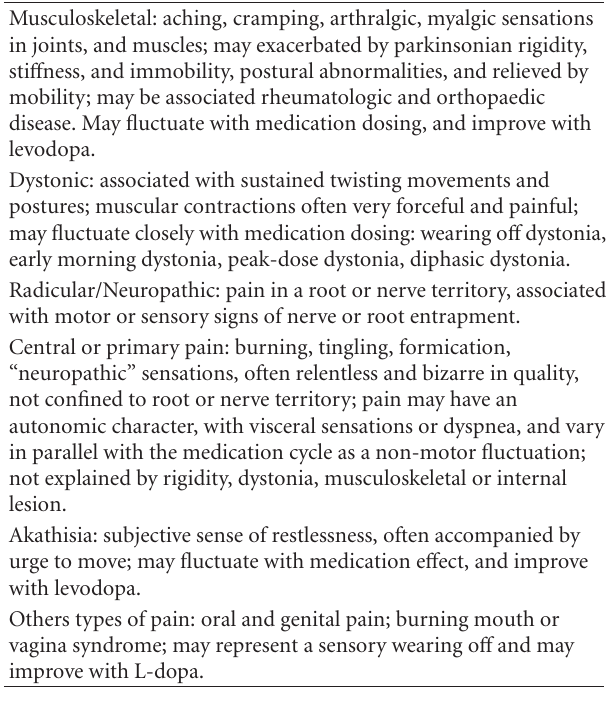
Table 2: Classification of pain in PD adapted by [89]. Musculoskeletal: aching, cramping, arthralgic, myalgic